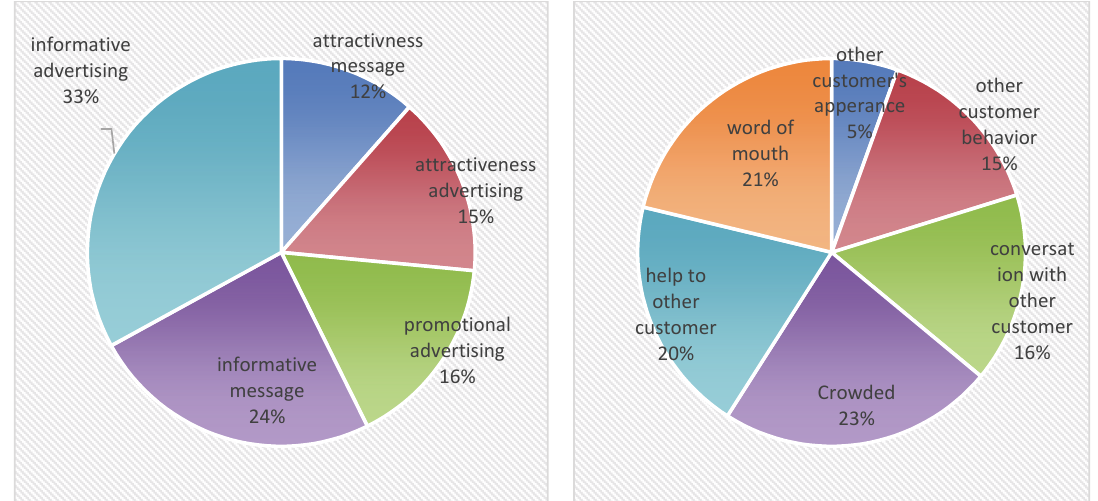
Fig. 7 . weight of sub-factor of communicative factor